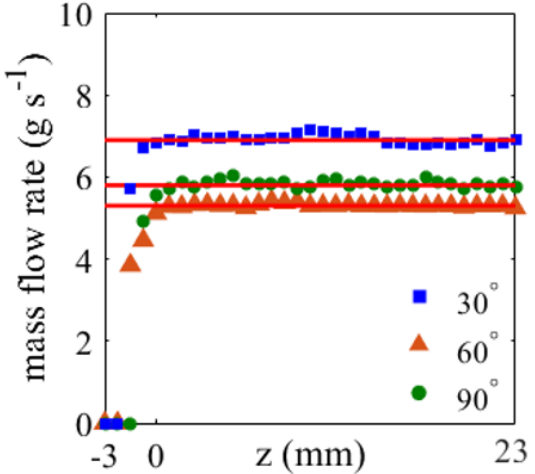
Fig. 7 . MRI (symbols) and gravimetric (lines) mass flow